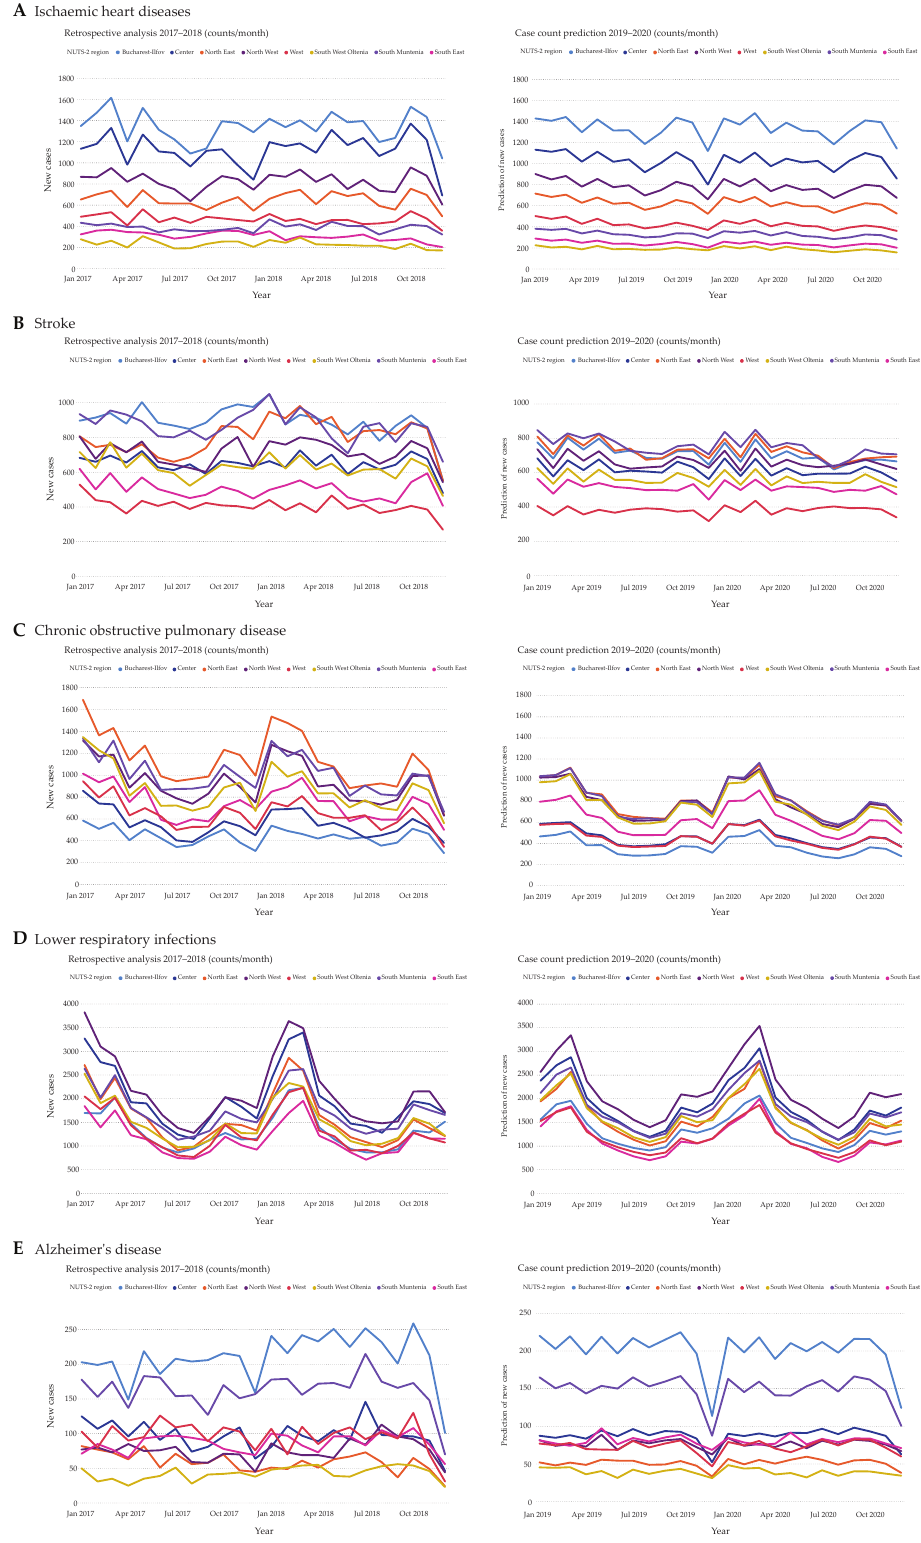
Figure 4. Comparison between total disease cases in the years 2017 and 2018 (left side) and predicted disease cases for the years 2019 and 2020 (right side). All hospitalized cases of ischemic heart diseases ( A ), stroke ( B ), chronic obstructive pulmonary disease ( C ), lower respiratory infections ( D ), and Alzheimer’s disease ( E ) were plotted on a monthly basis against the predicted